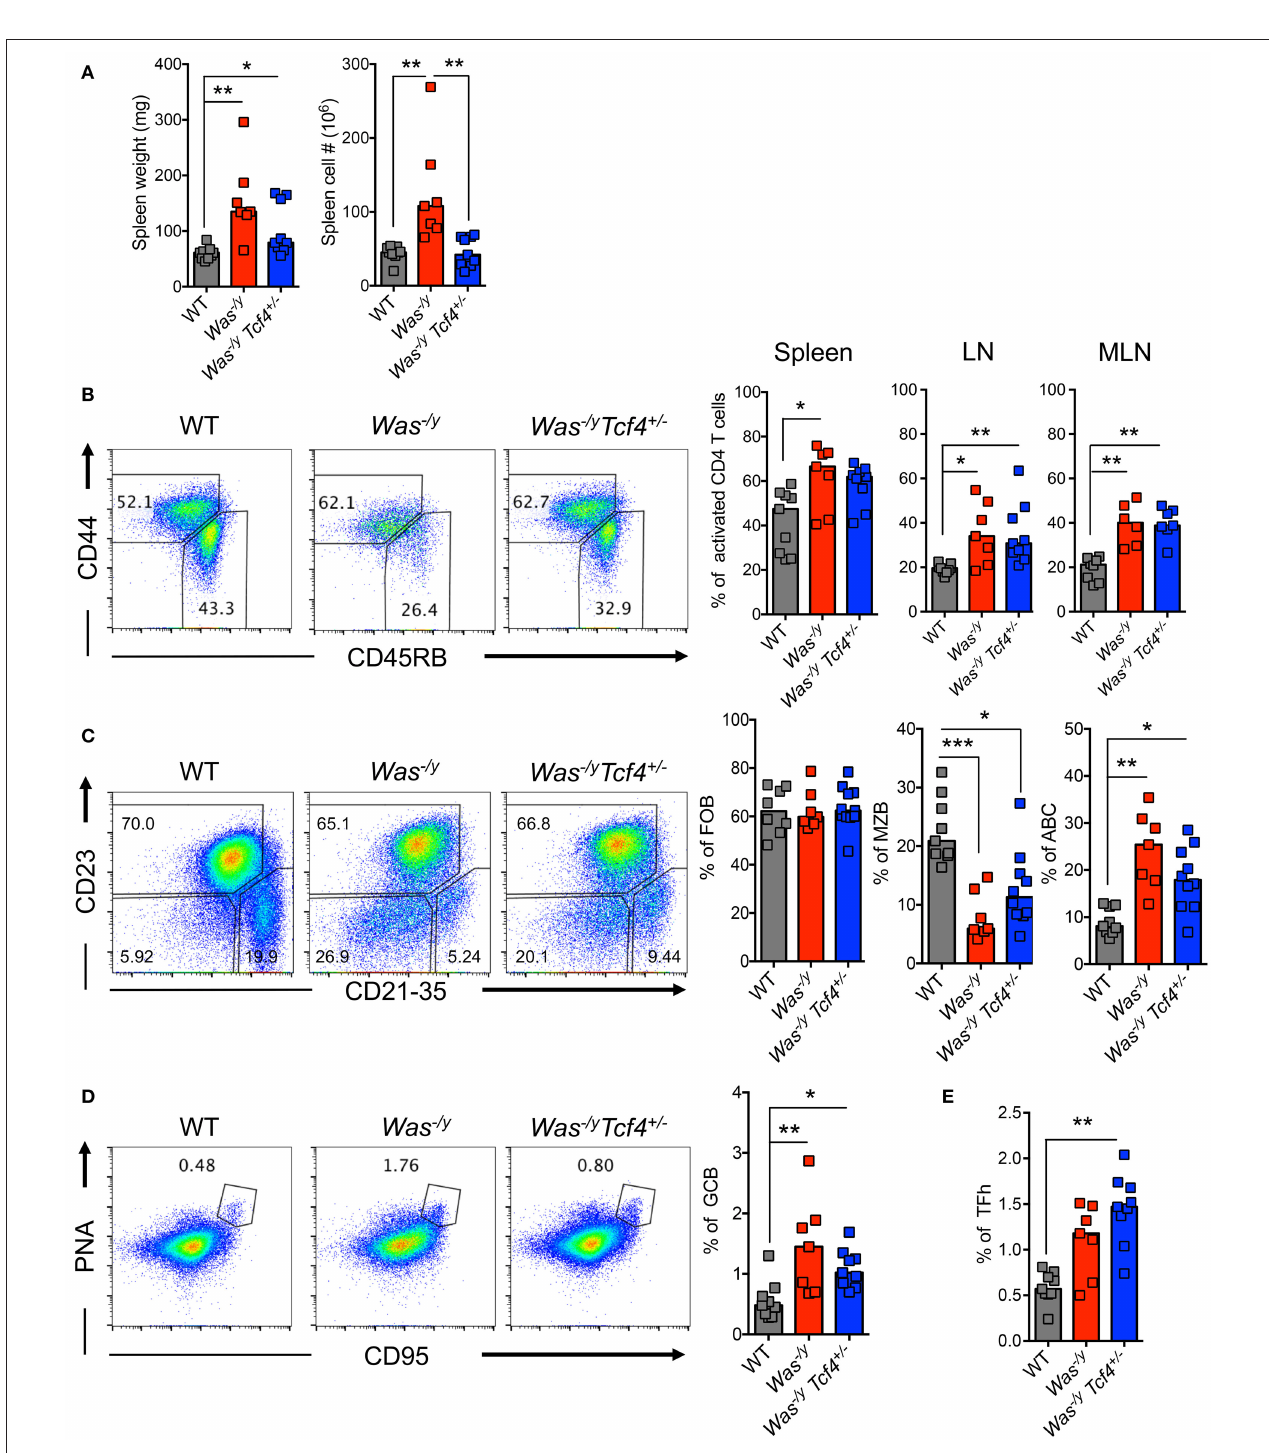
FIGURE 2 | No change in overall immune activation upon Tcf4 haplodeficiency in Was -deficient mice. Analysis of WT, Was − / y or Was − / y Tcf4 + / − mice at 30 weeks of age. (A) Spleen weight and cellularity were measured from individual mice. (B–E) T and B lymphocyte populations within the spleen were analyzed by flow cytometry. (B) The frequency of both naïve (CD44 − , CD45RB + ) and activated (CD44 + , CD45RB − ) cells among live CD4 + T cells was determined in the spleen, LN and MLN of the indicated animals. (C) The frequency of follicular B cells (FOB, CD23 + , CD21 − ), marginal zone B cells (MZB, CD23 − , CD21 + ) and age associated B cells (ABC, CD23 − , CD21 − ) among mature B220 + CD93 − B cells was measured. (D) Analysis of germinal center B cells (GCB, PNA + and CD95 + among total B220 + B cells) and (E) T follicular helper cell (TFh, CXCR5 + , PD1 + , and BCL6 + among CD4 + T cells) frequencies. Values from individual animals are shown and horizontal bars represent median. Data were pooled from 4 independent experiments and statistical significance estimated by Kruskal-Wallis test followed by a post-hoc Dunn’s multiple comparison test is indicated as follows * P ≤ 0.05, ** P ≤ 0.01, *** P ≤ 0.001.